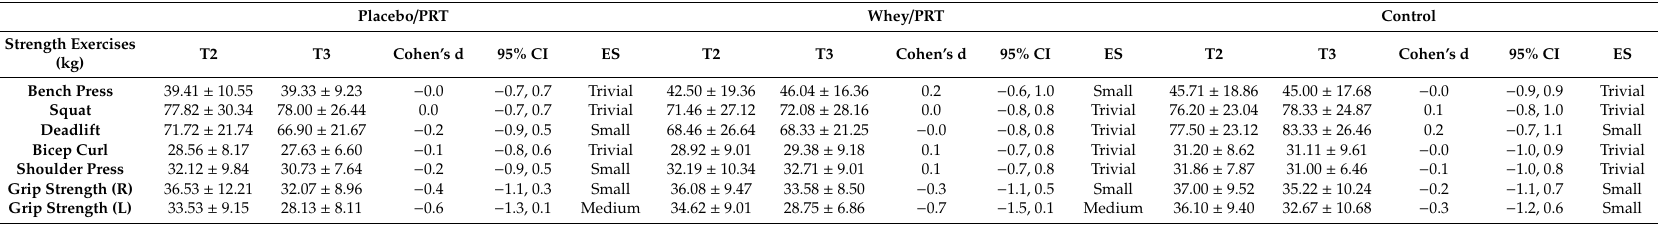
Table 5. E ff ect sizes (ES) of one-repetition maximum (1RM) strength indices from T2 to T3 in the placebo / PRT, whey / PRT, and control in HIV-infected individuals receiving ART (Mean ±